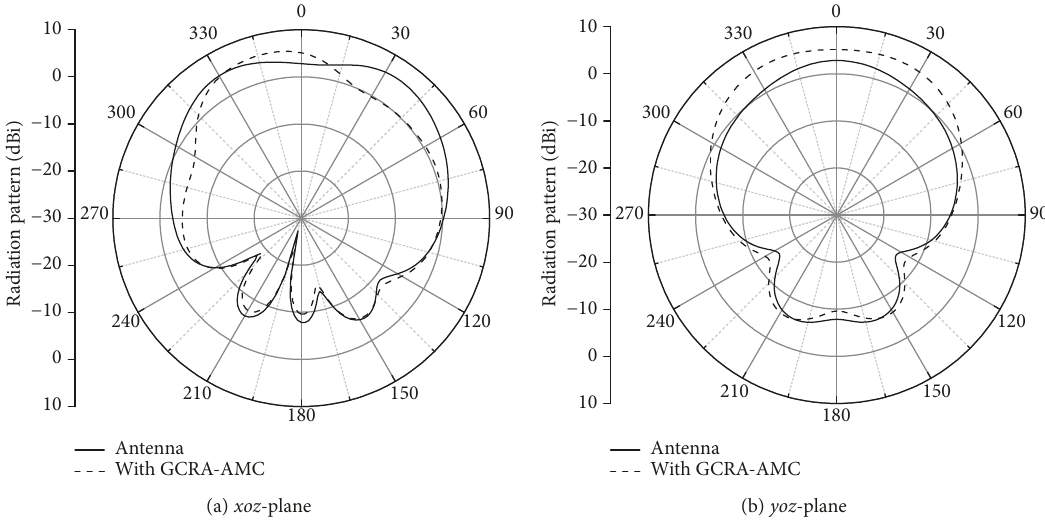
Figure 8: The comparison of the radiation patterns of the microstrip antenna with and without GCRA-AMC.